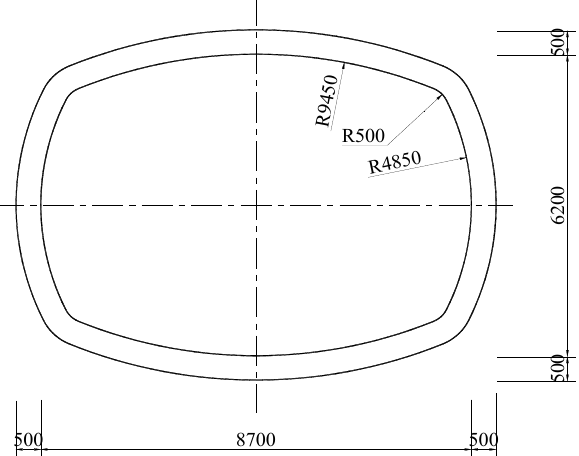
Figure 1. Sub-rectangular express tunnel in Shanghai [22], distances in millimeters.